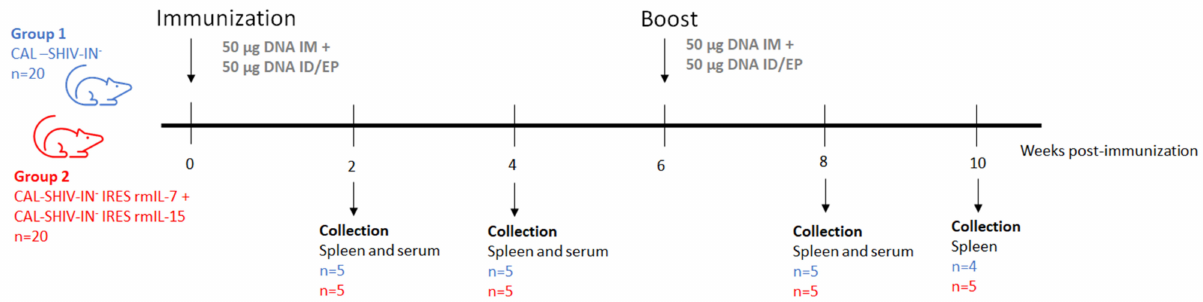
Figure A2. Immunization of BALB/cJ mice: Twenty mice per group were immunized with CAL- SHIV-IN − vaccines (group 1) or co-immunized with CAL-SHIV-IN − IRES IL-7 and CAL-SHIV-IN − IRES IL-15 (group 2) by intradermal route + electroporation (ID/EP), and by intramuscular route (IM) as described in materials and methods. A homologous vaccination booster was administered 6 weeks later. At weeks 2, 4, 8 and 10 post-immunization, spleens were harvested to monitor and evaluate the cellular responses and blood samples for the detection of HIV-specific Abs in